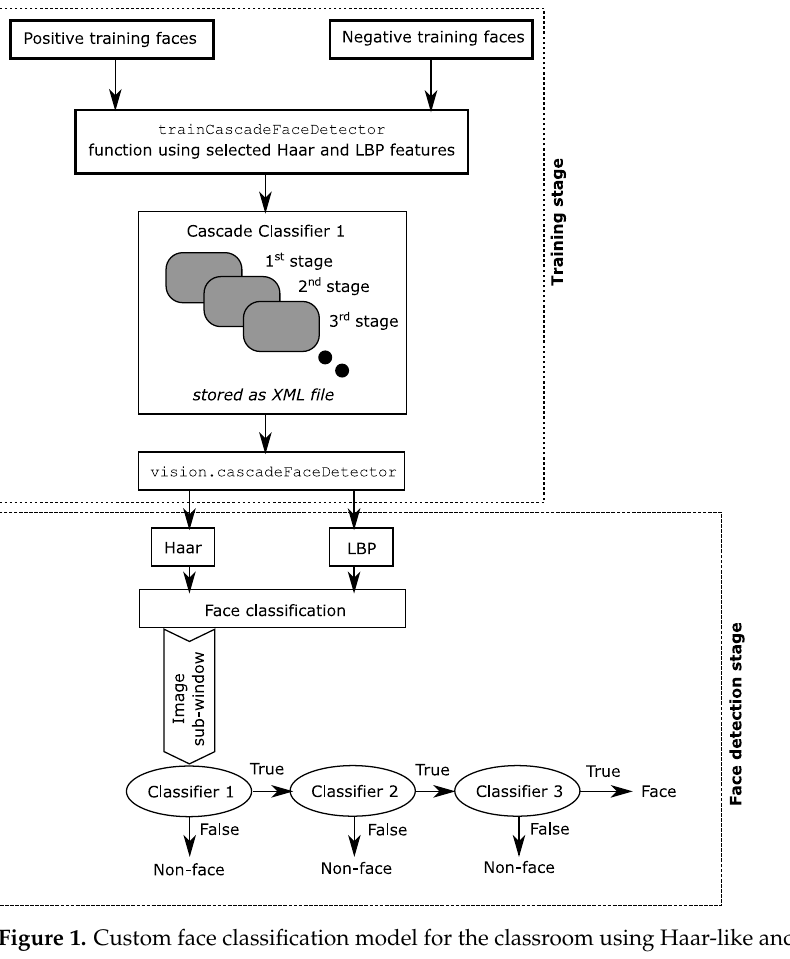
Figure 1. Custom face classification model for the classroom using Haar-like and LBP features.